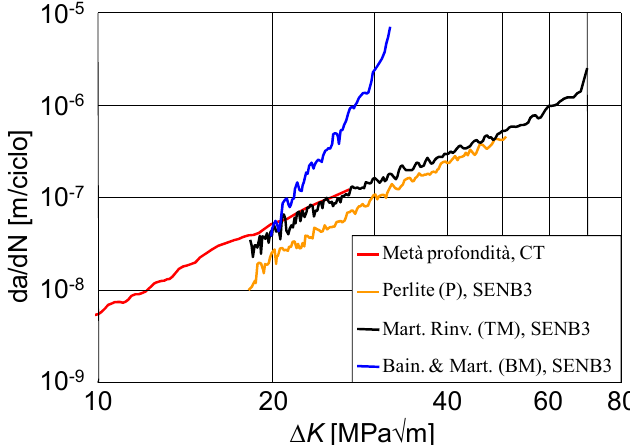
Figura 5: Acciaio 1.2738: campioni SENB3 trattati ad ottenere le strutture indicate (perlite-P, martensite rinvenuta-TM, bainite e